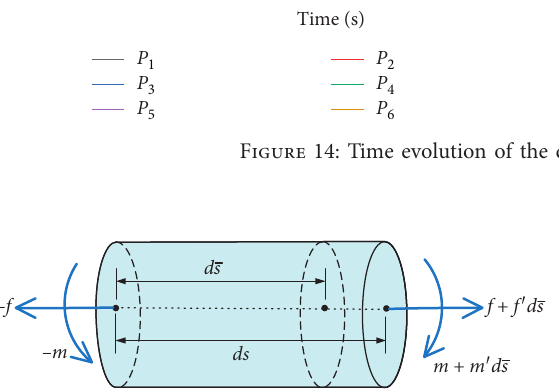
Figure 15: Equilibrium of infinitesimal element of a geometric nonlinear spatial beam with initial helix centroid